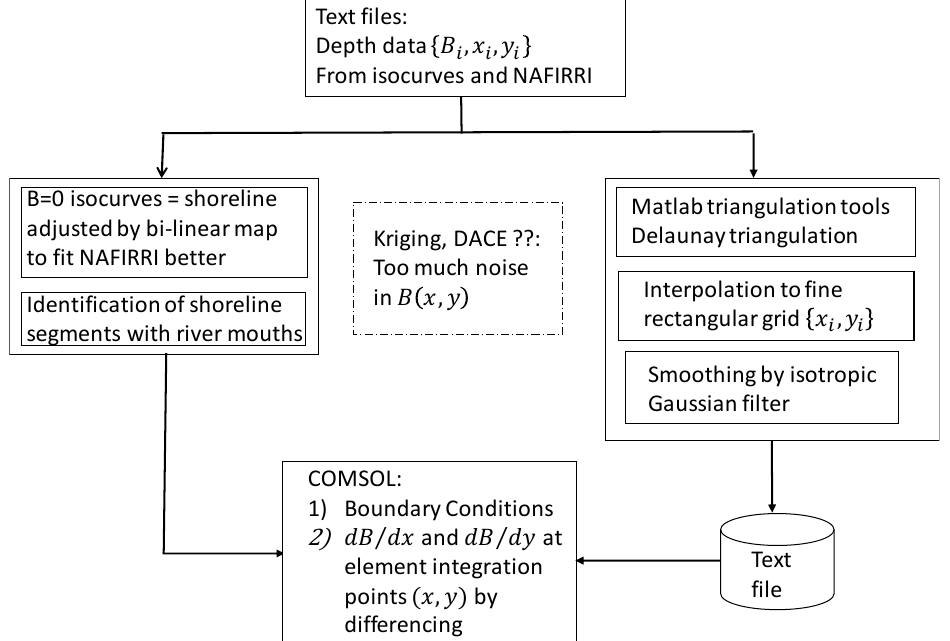
Figure 3. Development of bathymetry and boundary condition data.